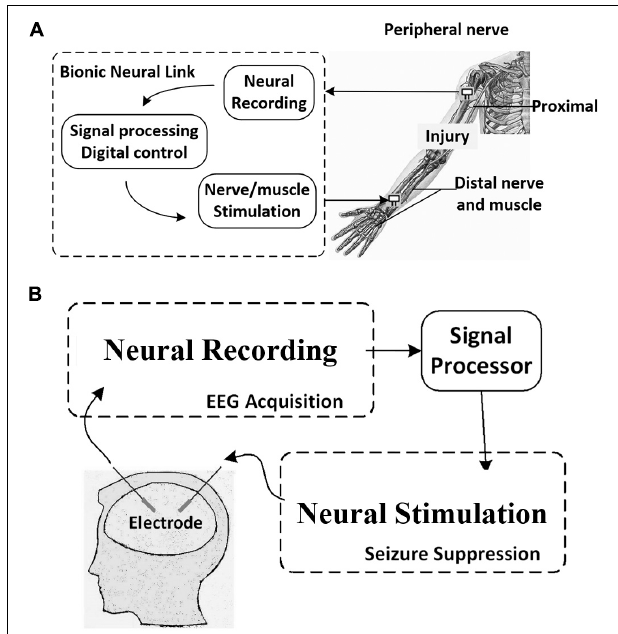
FIGURE 1 | Concept of (A) the Bionic Neural Link and (B) the epileptic seizure detection and suppression using neural recording and stimulation